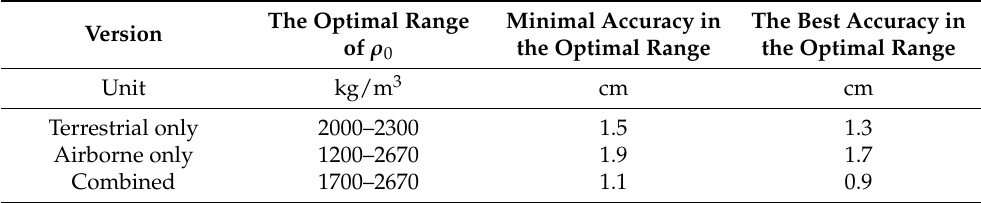
Table 1. Optimal ranges of ρ 0 values and estimated quasigeoid accuracy based on ζ m values in the GSVS17 profile